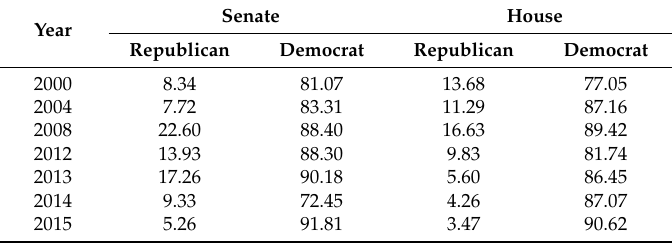
Table 1. LCV (League of Conservative Voting) national environmental scores of Congress. Senate House Year Republican Democrat